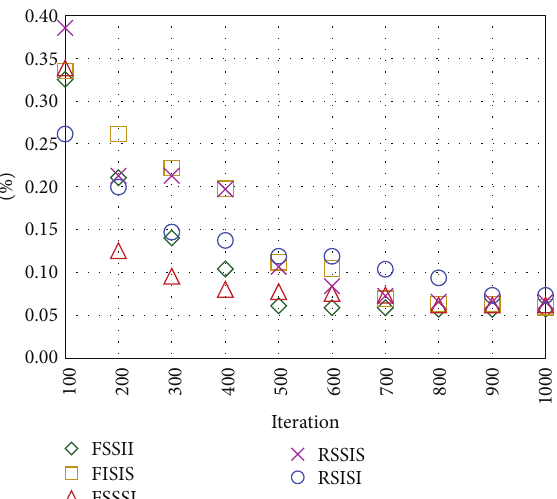
Figure 1: Average-solution-value-deviation-over-iteration plots of FSSII, FISIS, FSSSI, RSSIS, and RSISI.